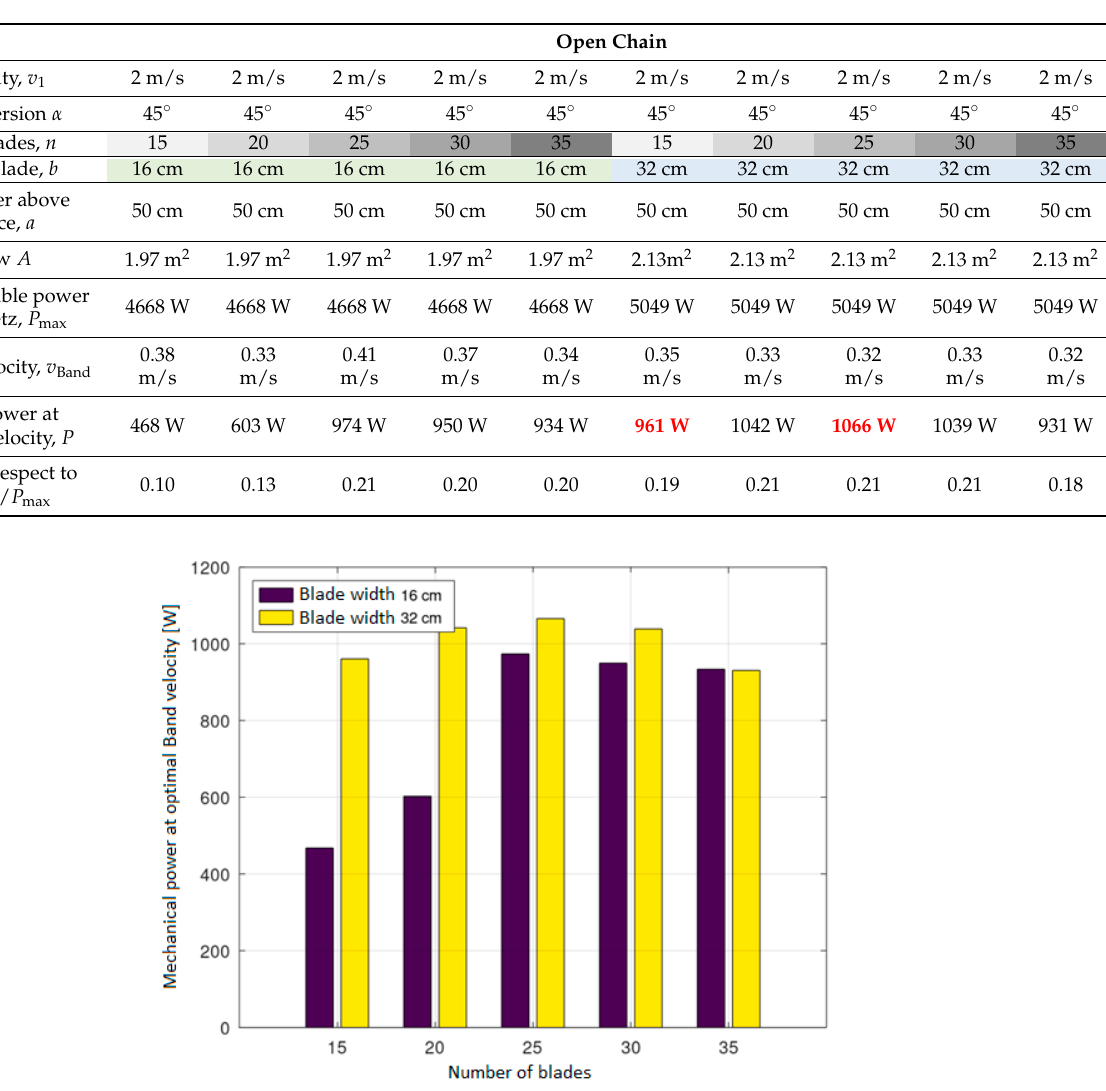
Table 4. Result summary III for Open-Chain ECB (red color is one of the optimum variants which is mentioned later in the conclusions).